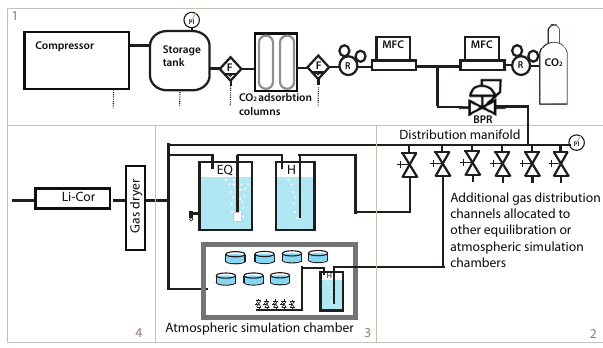
Figure 1. A general schematic of the system including gas mix- ing (1), gas distribution (2), equilibration tanks and atmospheric simulation chambers with temperature control (3), and verification of p CO 2 (4). A pair of MFCs (mass flow controllers) is present for each p CO 2 treatment. The components in 2 and 4 are also re- peated for each treatment for up to nine total equilibration tanks and up to nine atmospheric simulation chambers. Abbreviations in the schematic include pressure indication (PI), self-draining filter (F), regulator (R), backpressure regulator (BPR), humidifier (H), and equilibration tank (EQ). The distribution manifold is plumbed with flow meter valves so each gas distribution channel can be visually checked and adjusted for flow. Dotted lines indicate drain